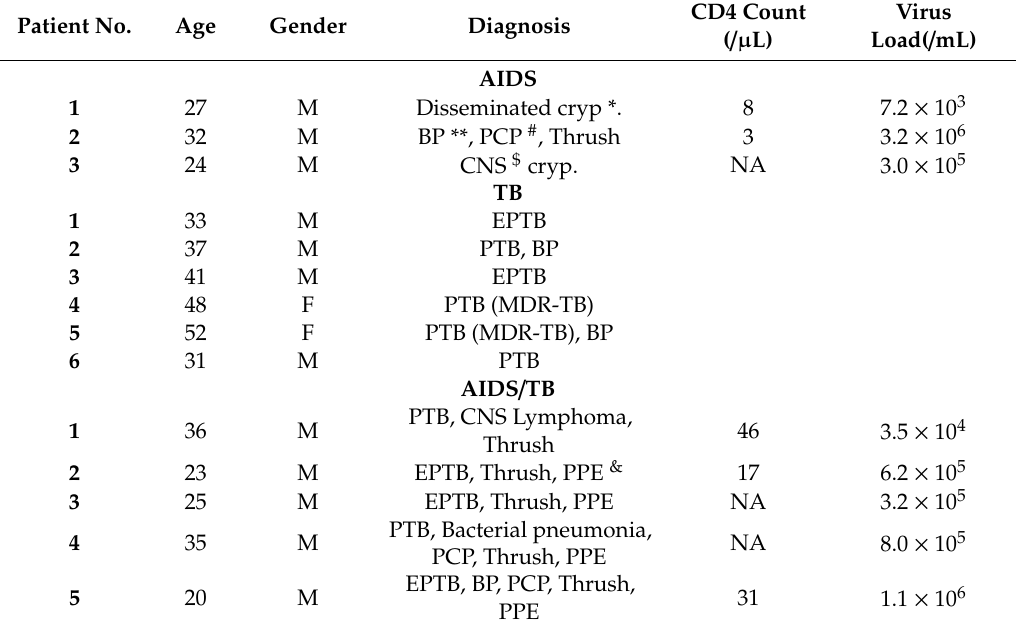
Table 2. Clinical features of dead patients .